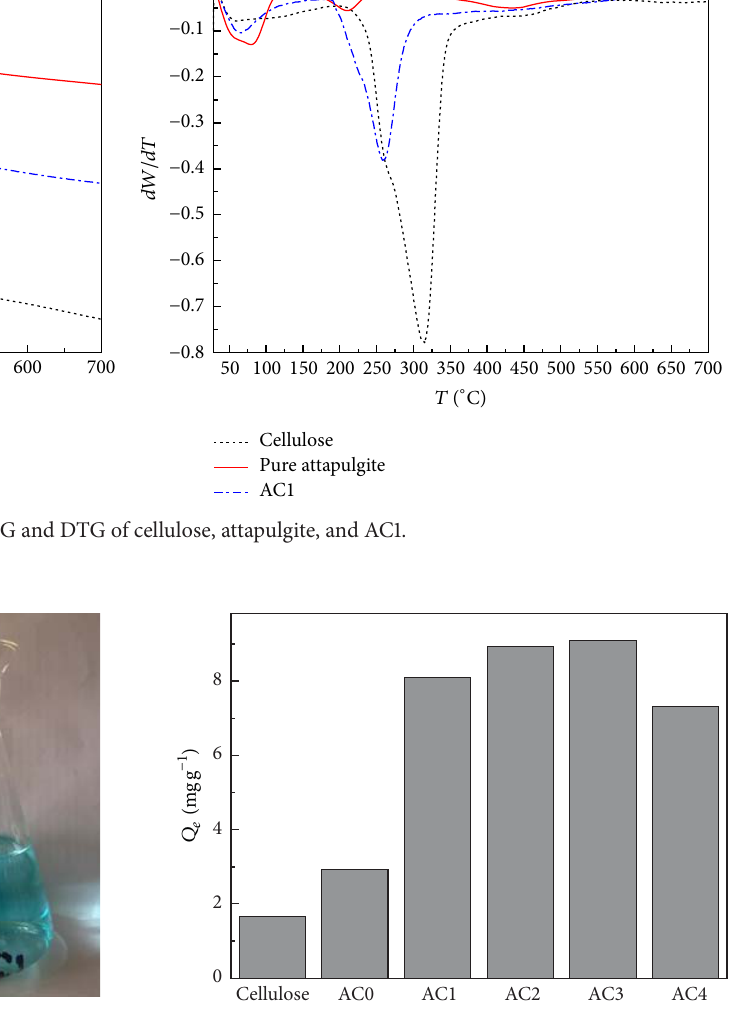
Figure 7: Adsorption capacity of six samples (cellulose bead, AC0, AC1, AC2, AC3, and